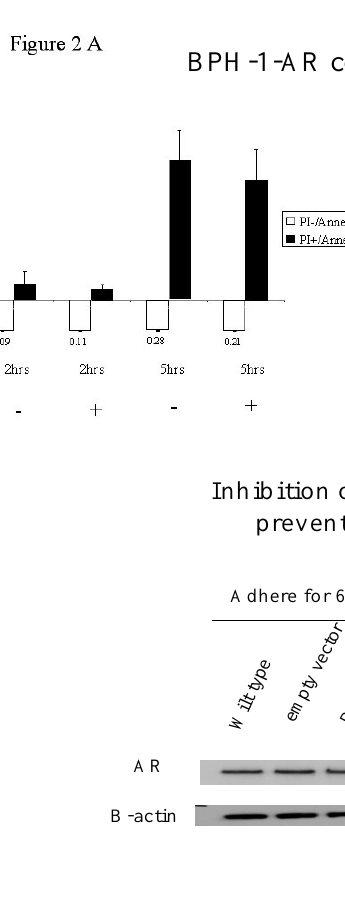
Figure 2 . A . Suspension induced apoptosis in BPH-1-AR cells. BPH-1 cells were suspended for 2 or 5 hours with or without stimulation of R1881 before harvesting. Double staining of Anexin V-FITC and propidium iodide( PI) were done according to manufacturer’ instruction(Alexis biochemicals, San Diego, CA).Open bar labeled with Annexin+/PI- represented early apoptosis , and solid bar labeled with Annexin+/PI+ represented late apoptosis/secondary necrosis.X